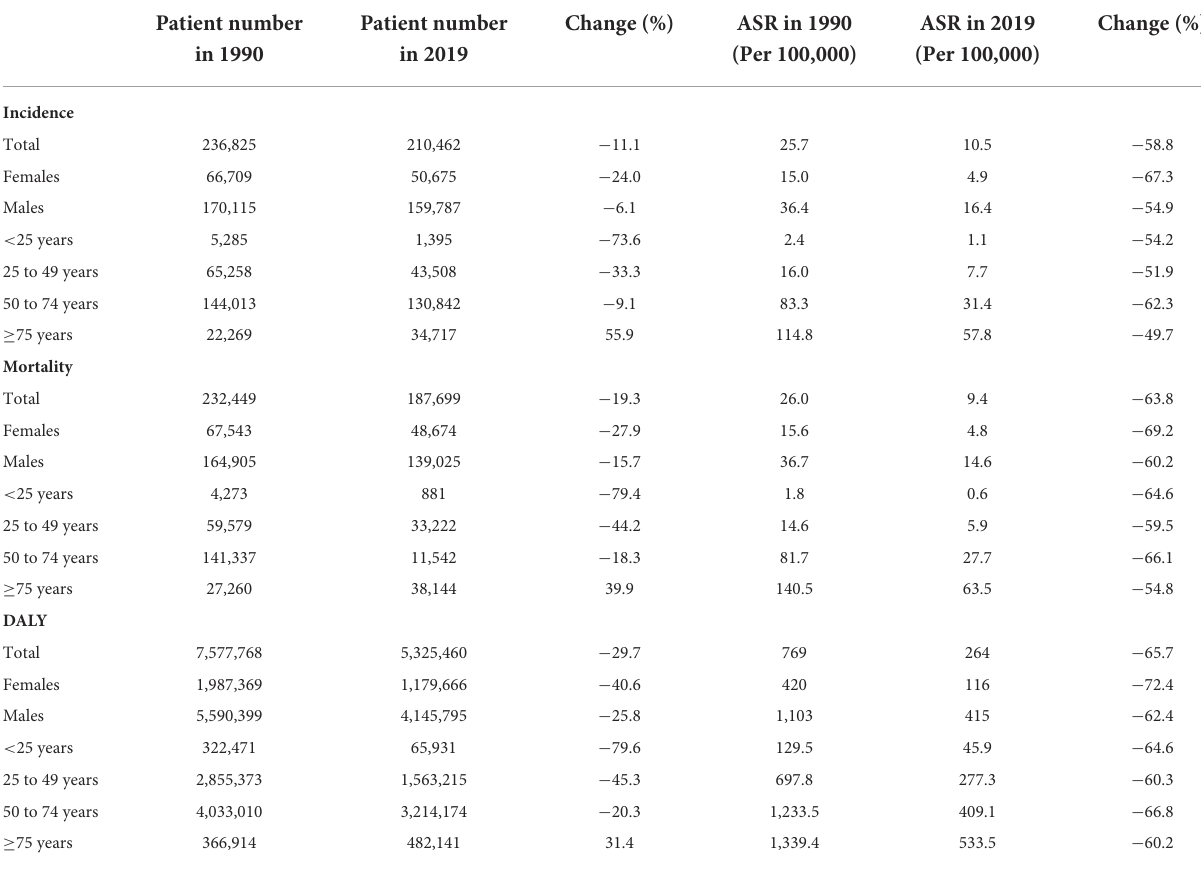
TABLE 1 Incidences, mortality, and DALY rates of liver cancer in China in 1990 and 2019. Patient